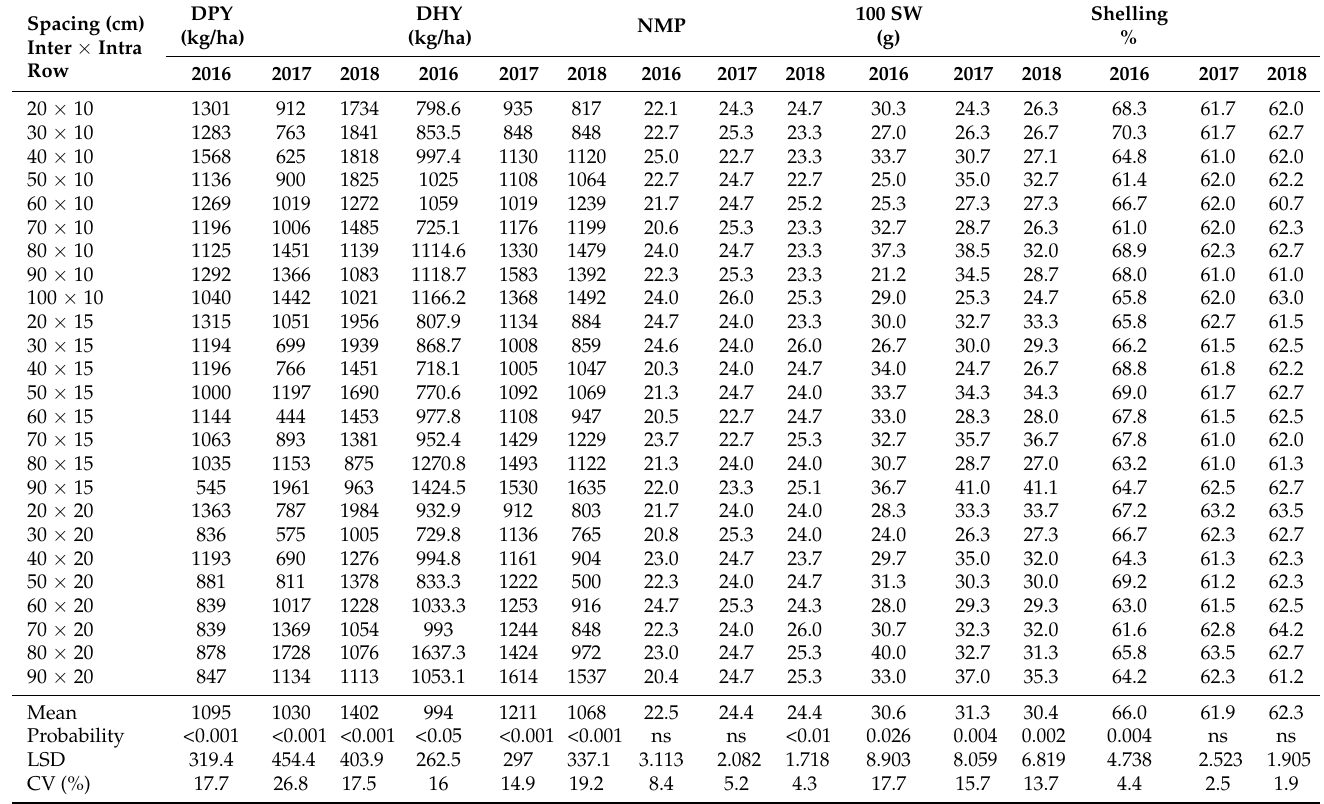
Table 3. Mean performance of spacing treatments for DPY, DHY, NMP, 100 SW, and shelling % during the rainy season in 2016, 2017, and